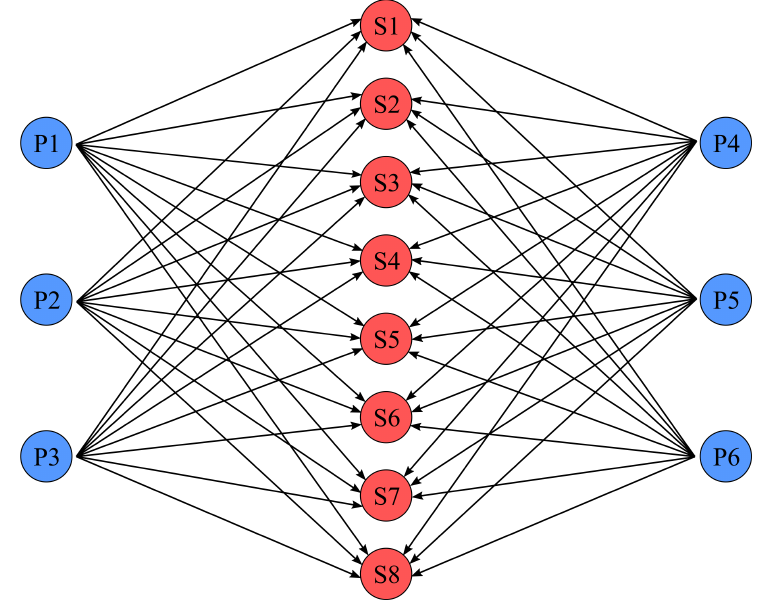
Figure 3. Network structure of transportation